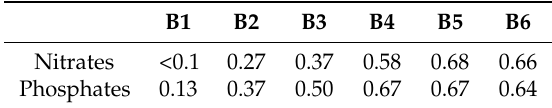
Table 1. The coefficient of determination ( R 2 ) between nitrates, phosphates, and measured remote-